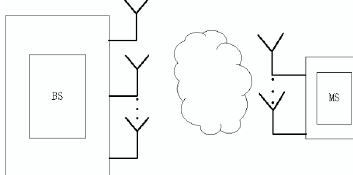
Fig. 1. The basic model of SU-MIMO.